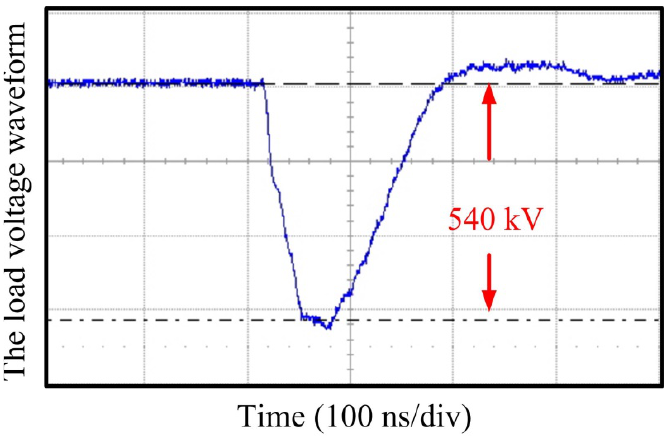
Figure 15. The load voltage waveforms on the water load.